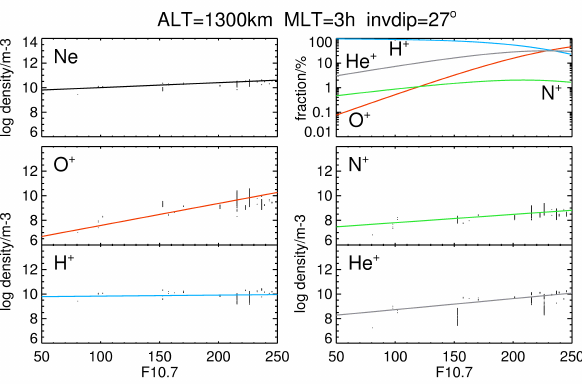
Fig. 9. Dependence of the logarithm of the individual ion densities, of the electron (=total ion) density, and of the relative ion densities on the solar activity level characterized by the actual day values of the F10.7 indes. Example for equinox, mid-latitudes 27 ◦ ± 15 ◦ , al- titude of 1300 ± 90km, and nighttime 3 ± 1h MLT. Points-measured values, lines-values calculated from the models (TTS relative ion density and electron density